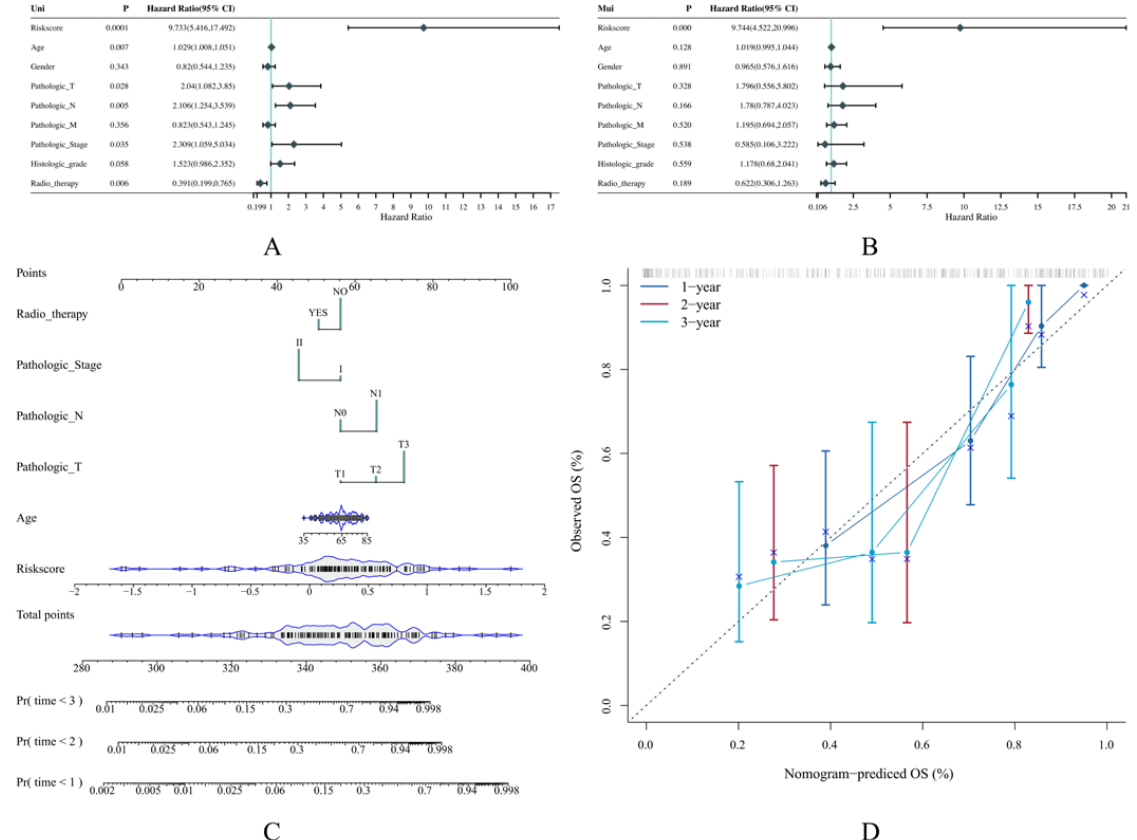
Figure 5. The establishment of a predictive nomogram according to our risk model. ( A , B ) The forest plot demonstrates the result of univariate and multivariate Cox regression for the risk score and other clinical factors such as age and gender. ( C , D ) The nomogram and its calibration curve that contains prognosis-related factors identified from univariate Cox regression. The dashed line in the calibration curve is the ideal line representing 100% accuracy. The more closely the ideal line to the curve, the more precise prediction the corresponding model can make.